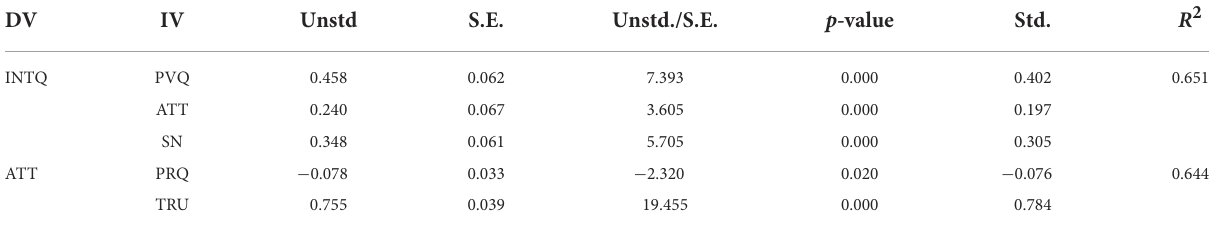
TABLE 6 Regression coefficient.